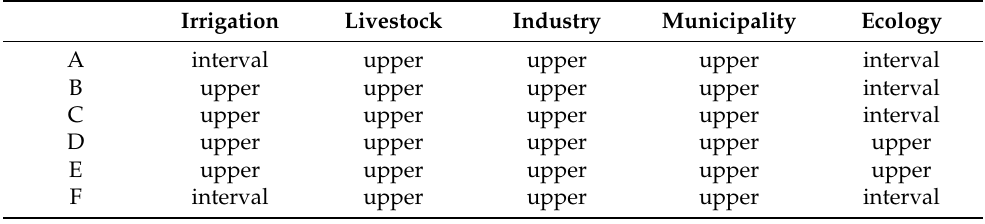
Table 11. Feature of water allocation